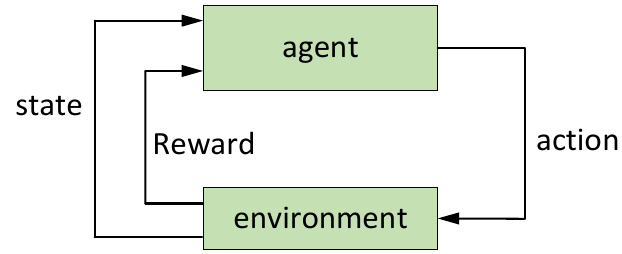
Figure 1. Schematic diagram of reinforcement learning.